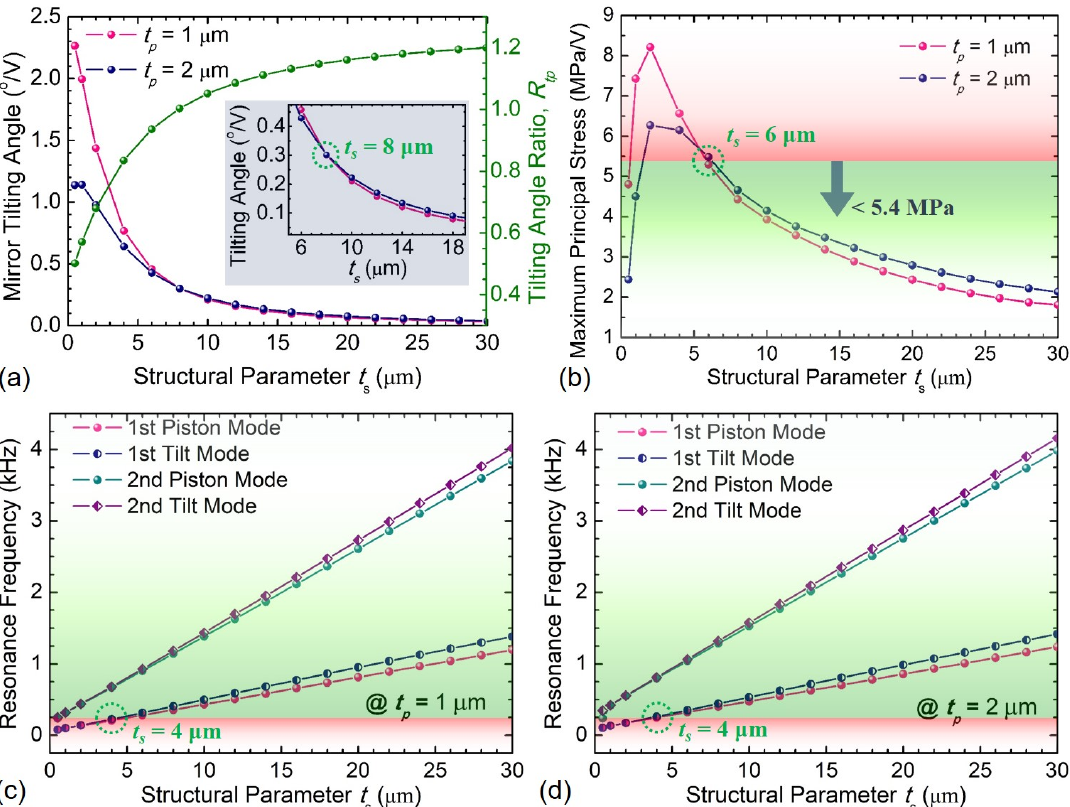
Sensors 2021 , 21 , x FOR PEER REVIEW Figure 7. Simulation results of the MEMS scanning mirrors varying with the thickness t s of the Si device layer: ( a ) mirror tilting angle, ( b ) maximum principal stress, ( c,d ) resonance frequencies of different modes.